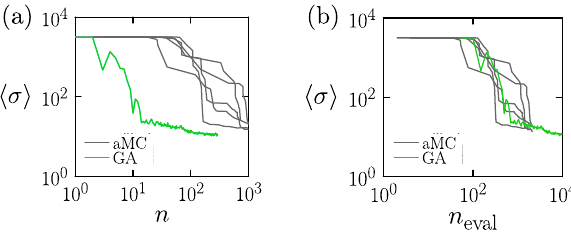
6. Supplement to Fig. 3. Similar to Fig. 3(f) but with heat Q ¼ Panels (a) and (b) show magnetization-reversal cycles accompanied by heat flow out of and into the system, respectively. Here, q ≡ Q=N (recall that N ¼ 32 2 ) and ˆ q ≡ q= 200